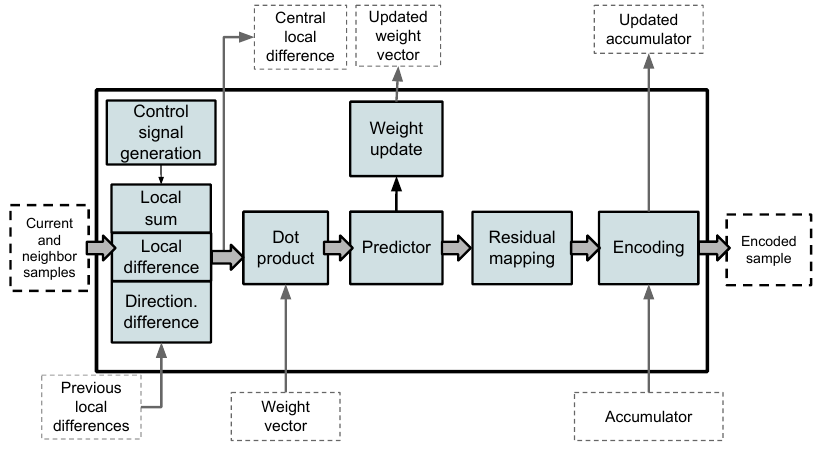
Figure 2. Overview of pipeline